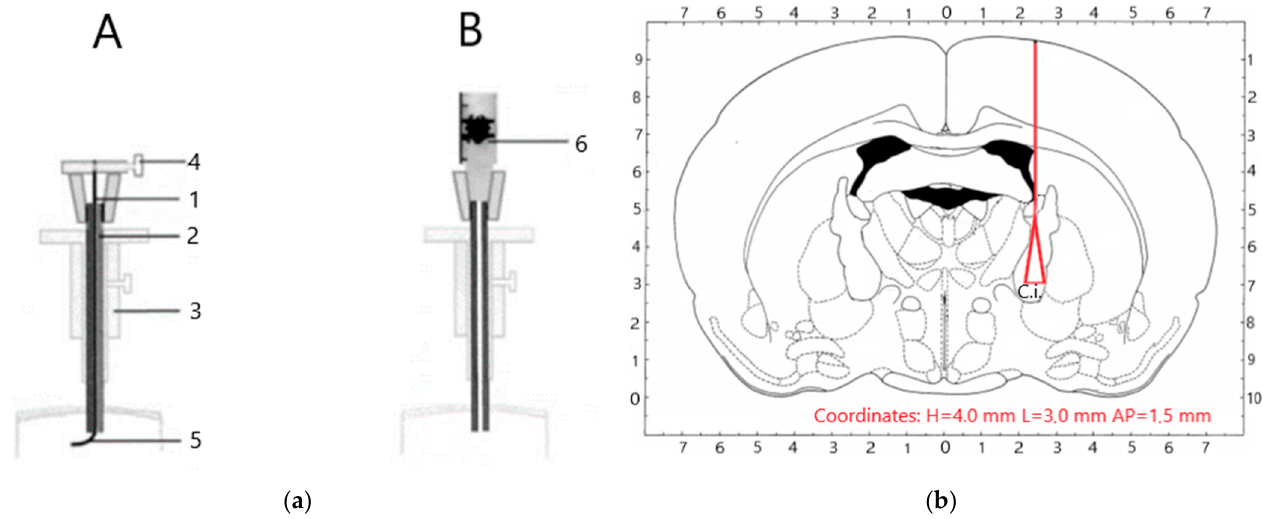
Figure 1. Scheme of the procedure of acute hemorrhagic stroke in the capsula interna: ( a ) Mandrel device: A—device is in position with extended mandrel; B—device after injection in the structure of the brain: 1—tungsten stylet-knife; 2—guiding needle cannula; 3—holder of the stereotaxic device; 4—latch top portion mandrel-knife; 5—cutting the bottom end mandrel-knife [20]. ( b ) Stereoscopic model [27] for simulating acute hemorrhagic stroke in the internal capsule. The red line and the red triangular area correspond to the post-surgery location of the damage. C.i.—Capsula Interna.